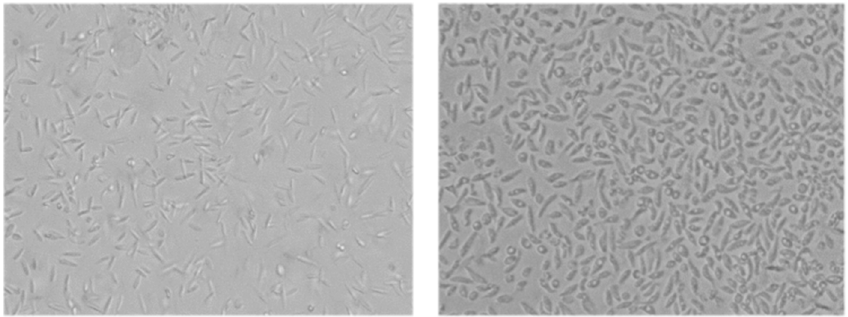
Figure 6. Left: control of non-treated promastigotes of L. donovani ; right: promastigotes of L. donovani treated with 7OSTS ( 2 ) at 10 µM. Images taken by EVOS FL inverted microscope (Invitrogen) (20X). Furthermore, ICZ analogues, K252a ( 6 ) and K252b ( 7 ), first isolated from the actinomycete Nocardiopsis [39] di ff er from STS ( 1 ) in the sugar moiety (Figures 1 and